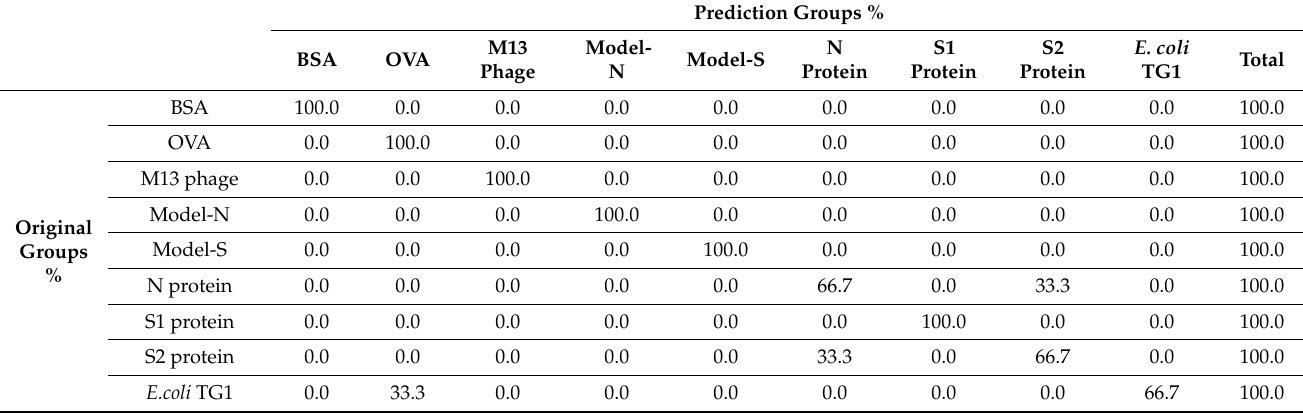
Table 4. Cross-validation for 3DFS.